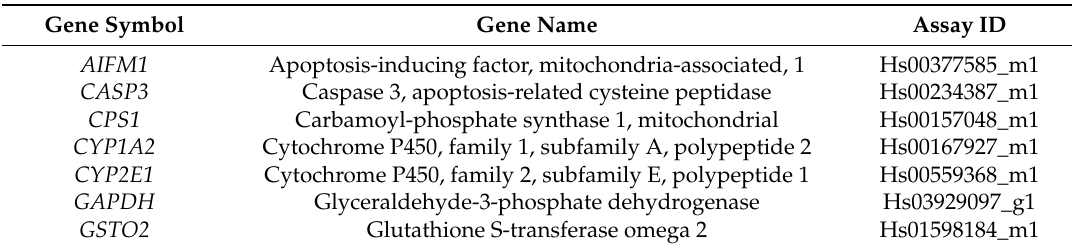
Table 3. Applied Biosystems TaqMan Gene Expression Assays ®